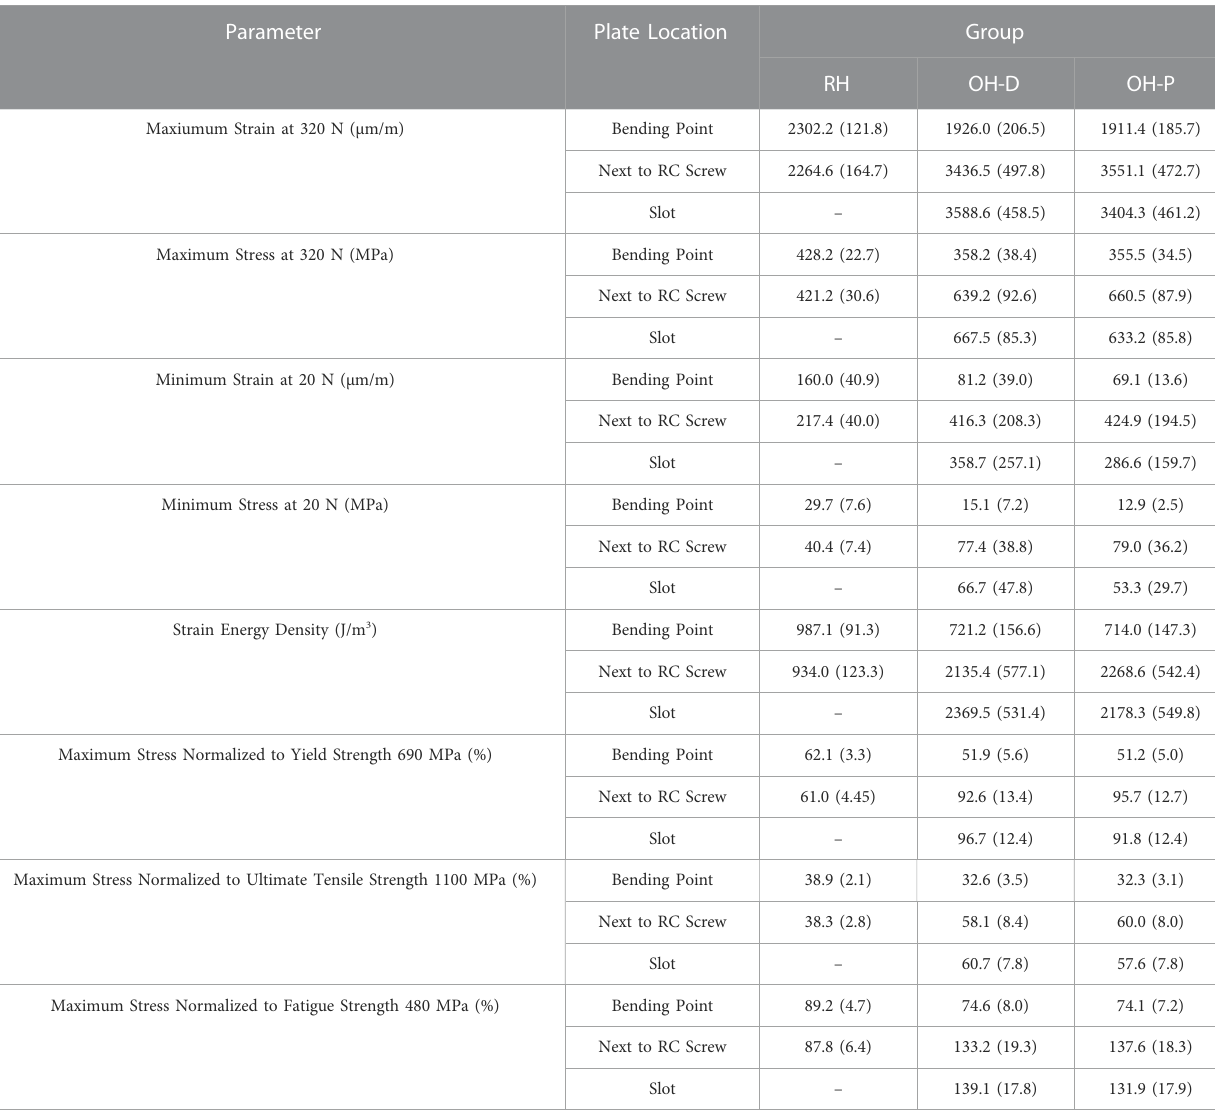
TABLE 1 Outcome measures based on previous experimental strain gauge measurements (Zderic et al., 2021), presented for each group separately in terms of mean value and